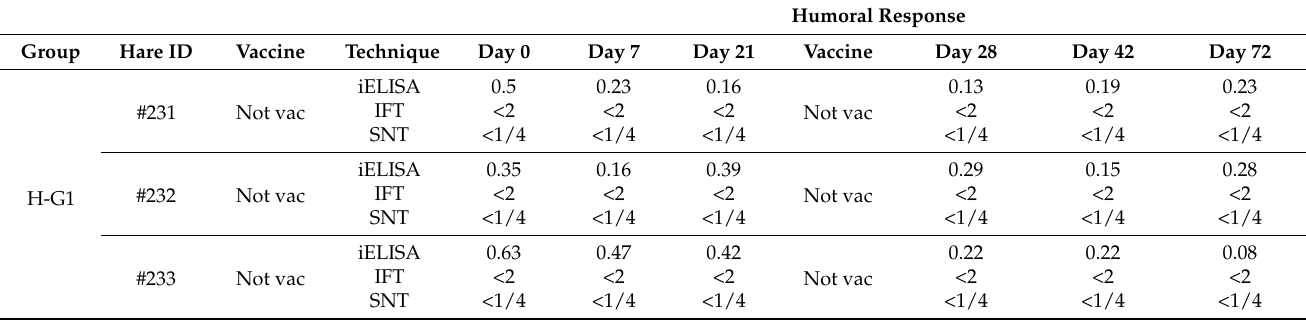
Table 1. Serological responses of hares (study 1) after vaccination and before challenge. Data were measured by indirect ELISA (RI10), immunofluorescence titration (IFT = titre in log2) and seroneutralization (SNT =